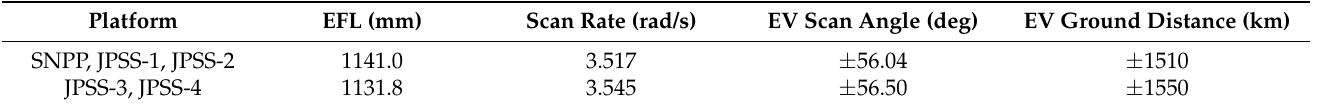
Table 5. Two sets of nominal EFLs and scan rates and EV coverages at altitude 828 km. Platform EFL (mm) Scan Rate (rad/s) EV Scan Angle (deg) EV Ground Distance